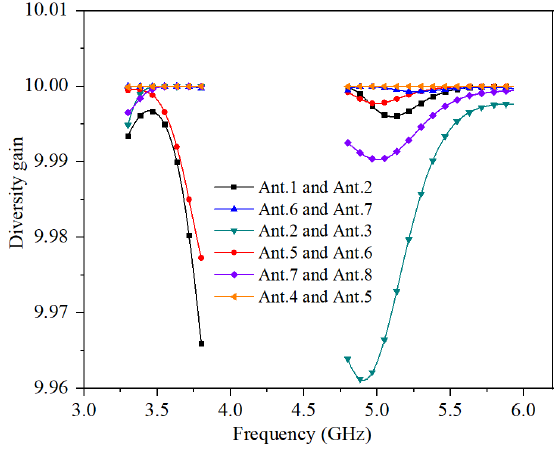
Figure 9. Calculated DG. The multiplexing efficiency (ME) is related to ECC in Equation (3). η 1 and η 2 are total efficiencies in Figure 7.